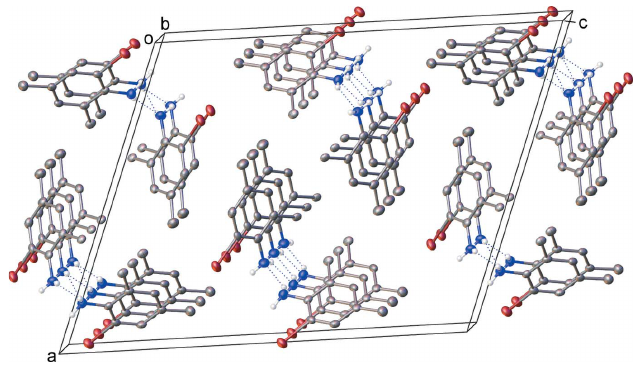
Figure 3 Packing diagram for compound 1 . Carbon-bound hydrogen atoms are omitted for clarity.